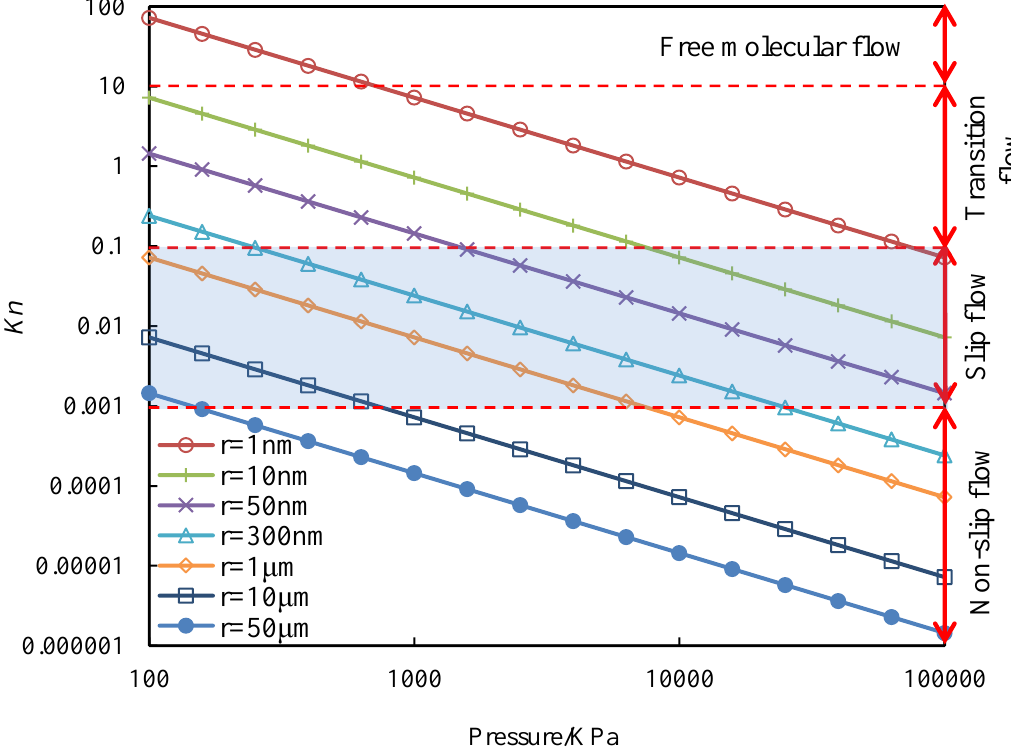
Figure 3. Knudsen number under different pressure and pore radii.